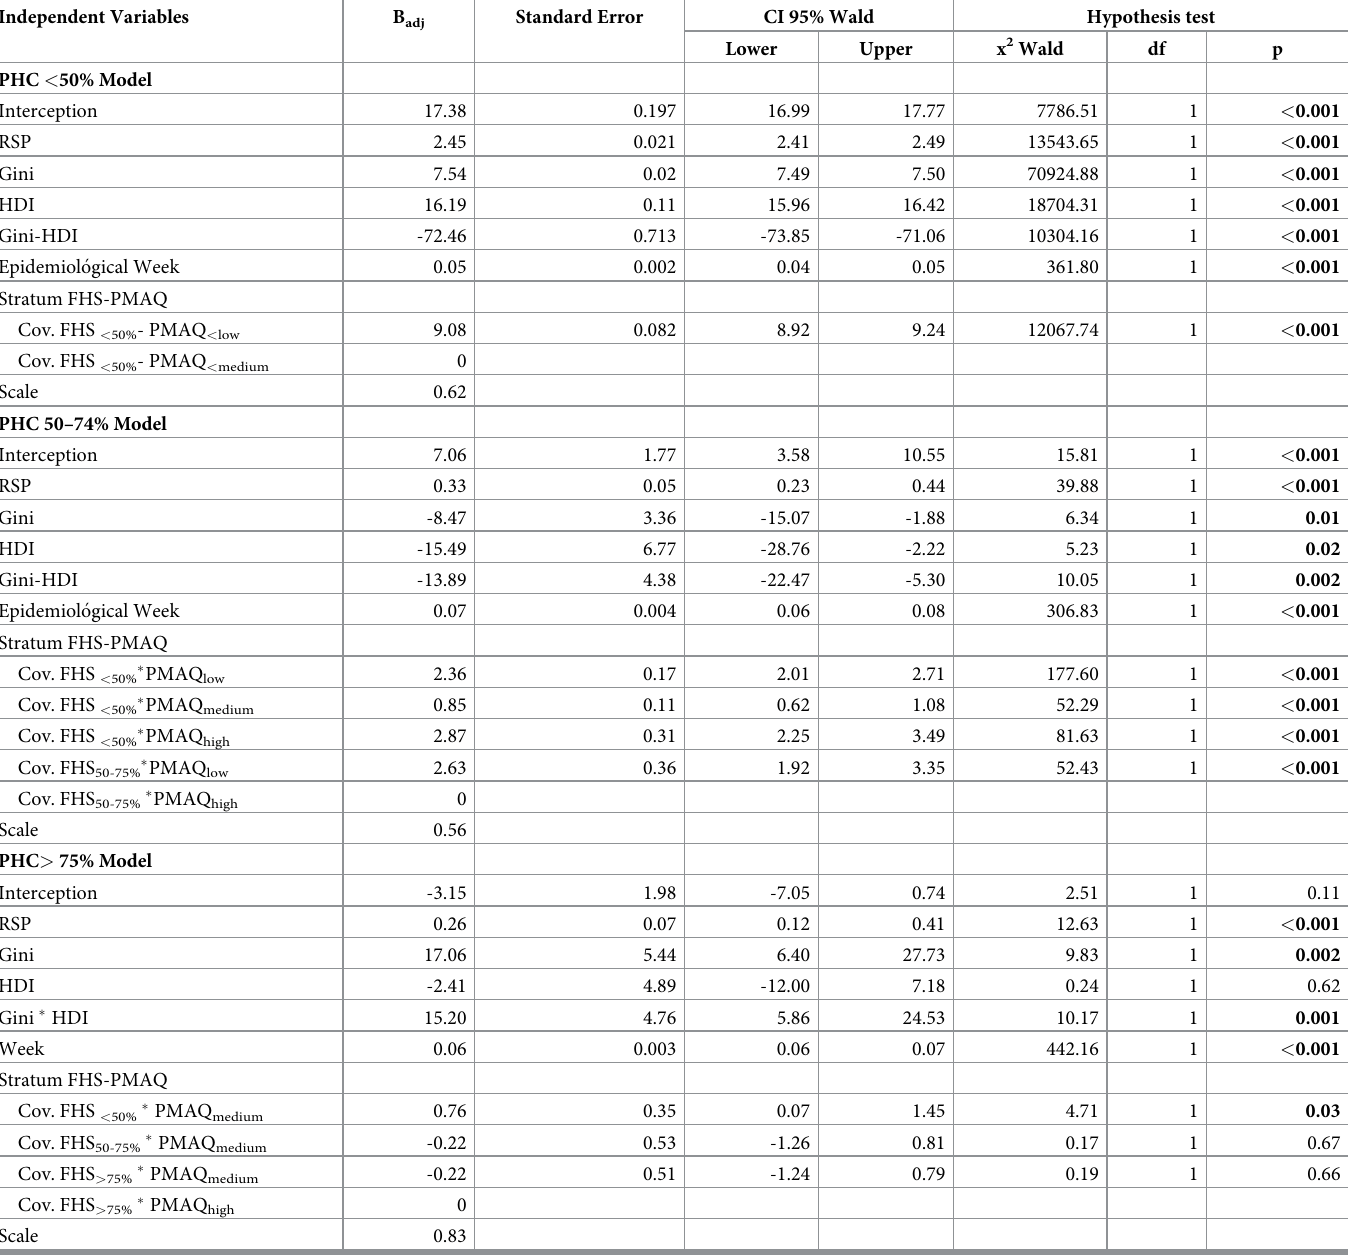
Table 2. Adjusted model for association with the incidence of Covid-19 in the largest cities of all federal units in Brazil stratified by the coverage of primary health care. Independent Variables B